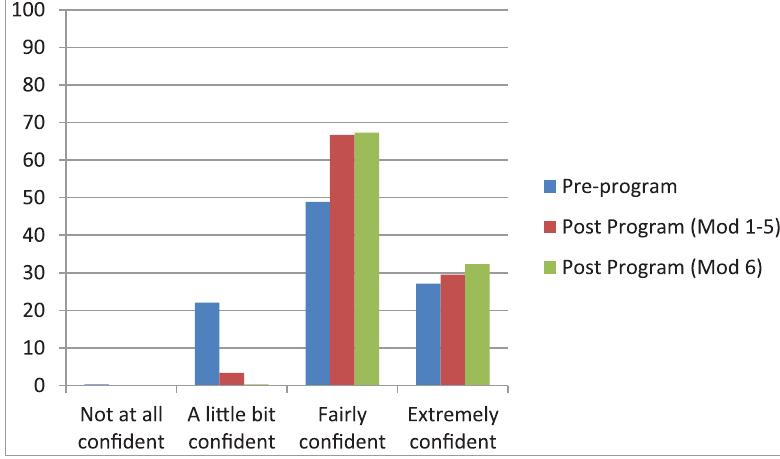
(Colour online) Changes in levels of confidence pre and post